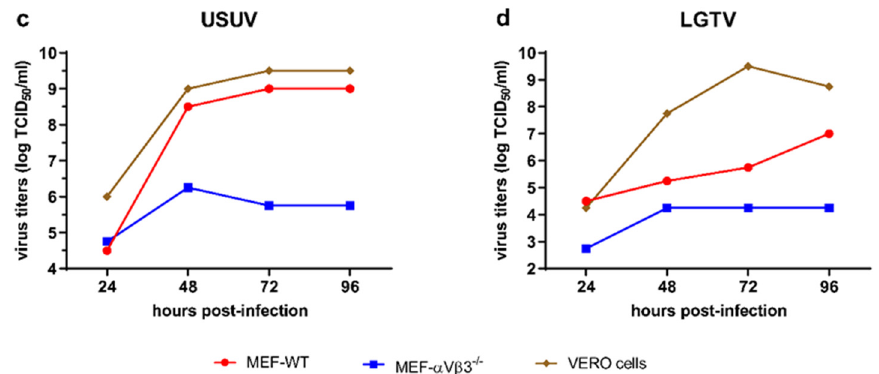
Figure 3. Replication kinetics of ( a ) YFV-17D, ( b ) WNV, ( c ) USUV and ( d ) LGTV in MEF-WT, MEF- α V β 3 − / − and Vero 76 cells. Cells were inoculated with these flaviviruses at a MOI of 0.1 and supernatants were harvested at 24, 48, 72 and 96 h post inoculation. Values represent virus titers determined by TCID 50 in Vero 76 cells over a period of 4 days post-infection.